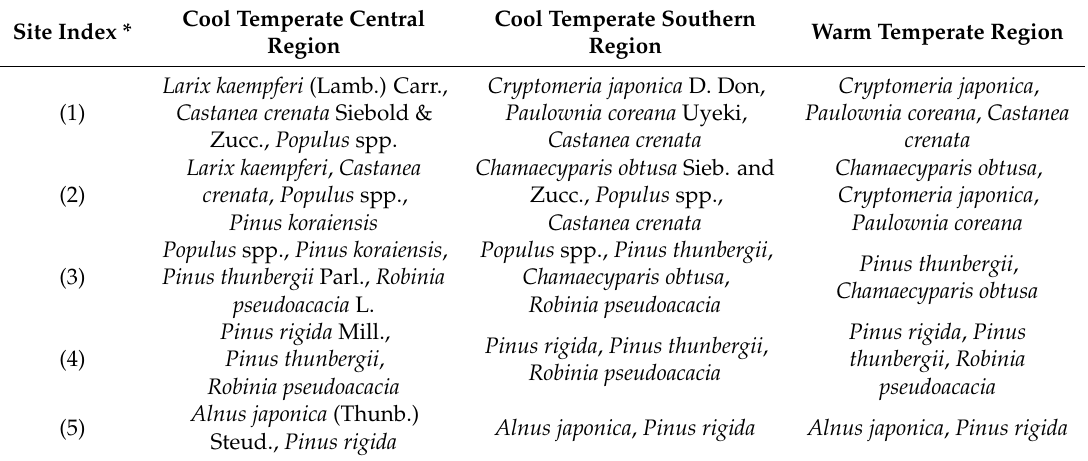
Table 2. Plantation species for the national forest restoration programs of South Korea in the 1970s